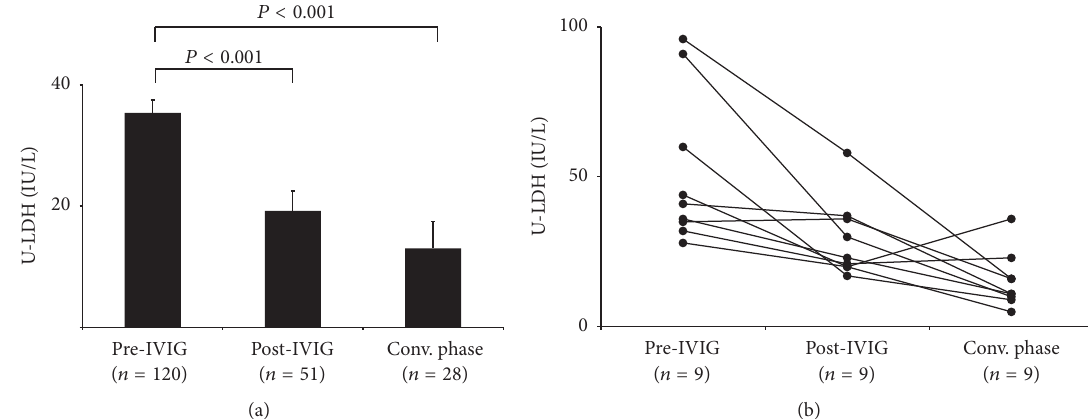
Figure 1: Comparison of total U-LDH activity among pre-IVIG, post-IVIG, and convalescent phases of KD (a) and the time course changes in the total U-LDH activity